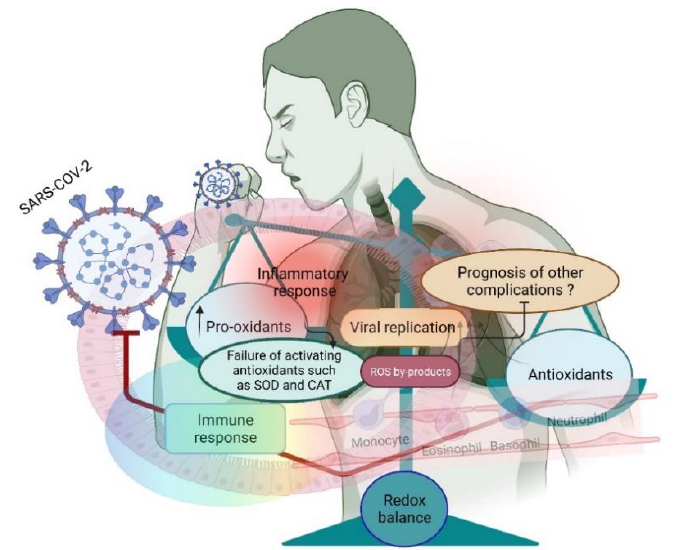
Figure 1. A small shift in the redox balance facilitates SARS-CoV-2 entry and further replication in the lungs. Entry of the virus induces an inflammatory response and increases the pro-oxidants to facilitate the host’s virus life cycle.